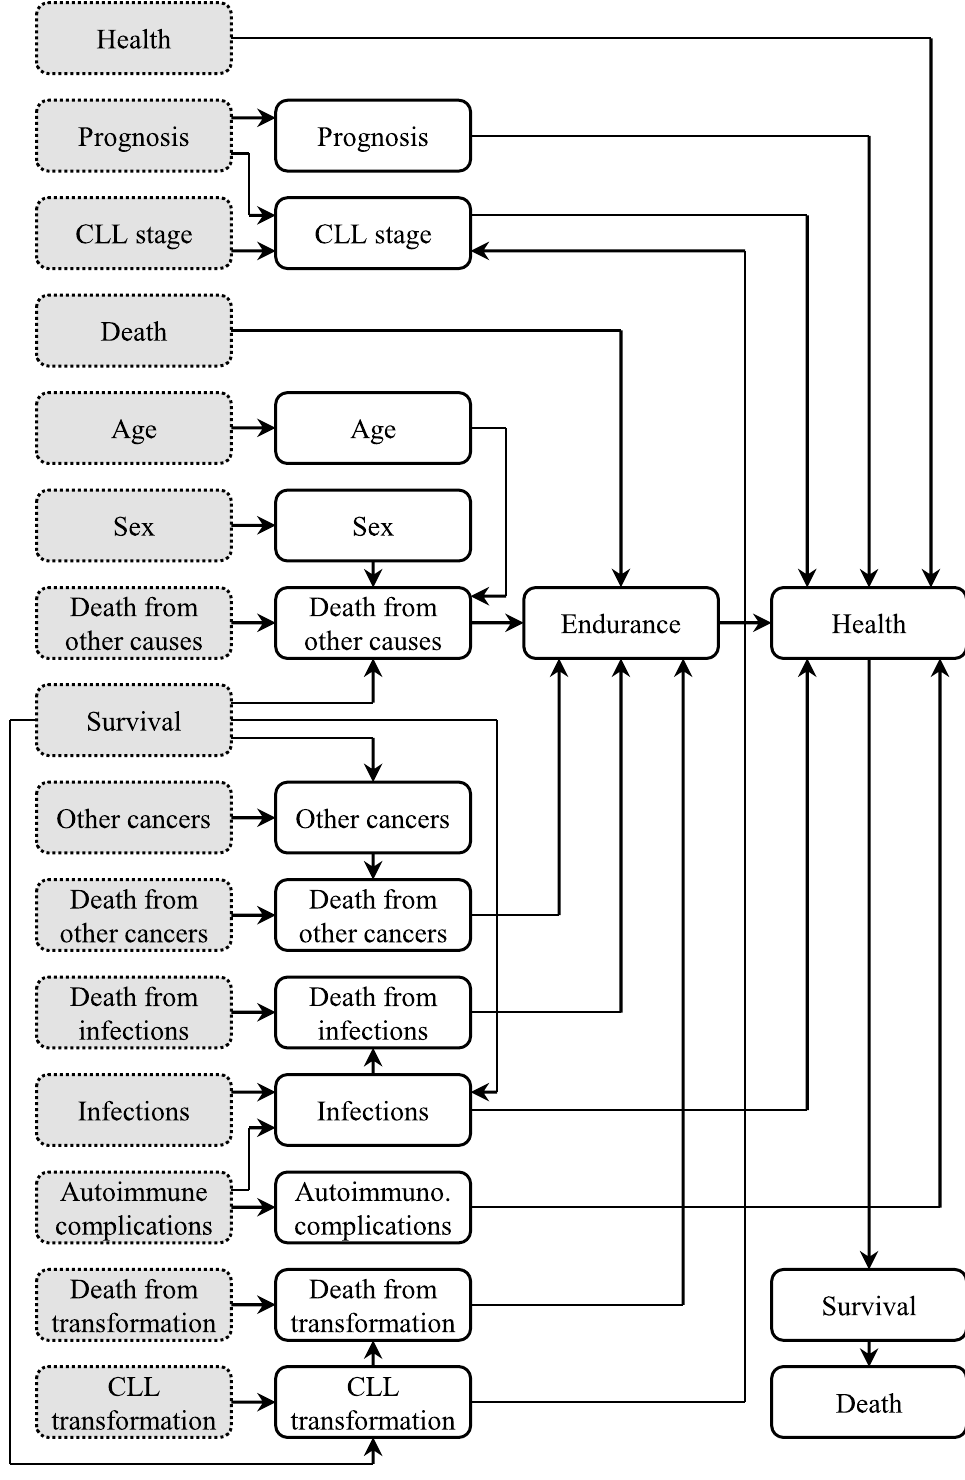
Figure 1. Diagram of the Health Status Network (HSN). The network nodes at moments t-1 have gray background and dotted borders, and the nodes at moment t have white background and solid